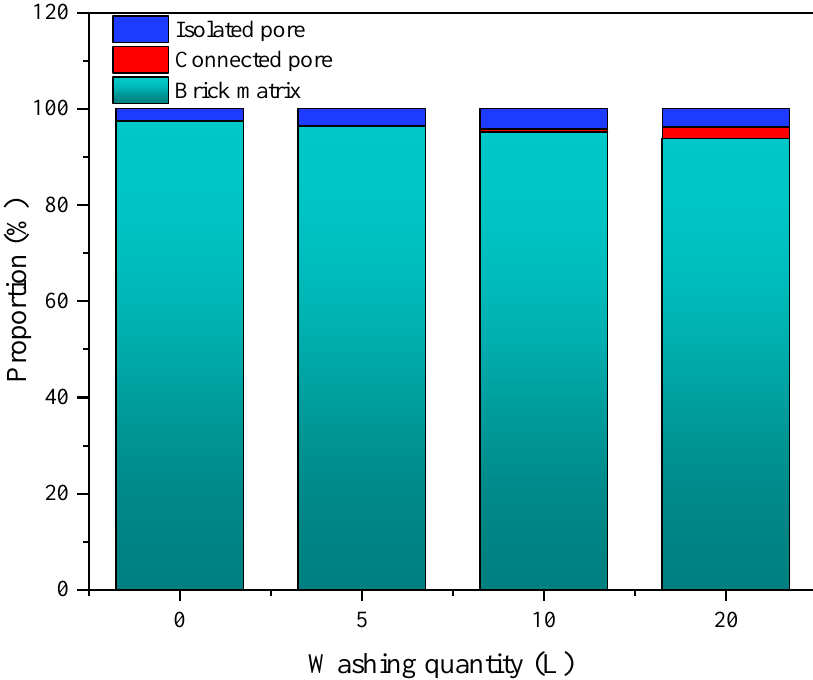
Figure 8. Analysis results based on 3D CT scanning images.